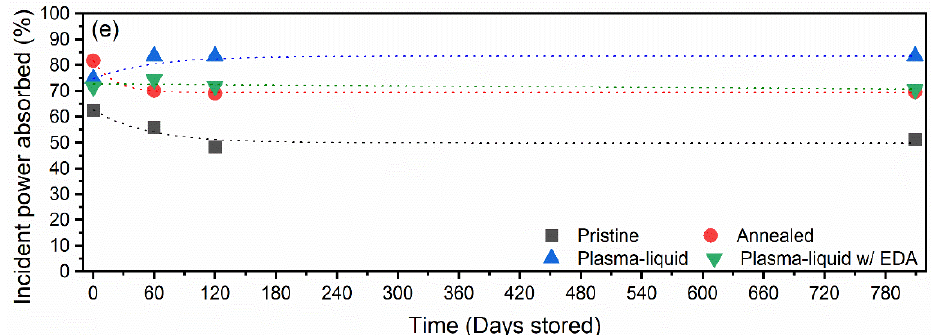
Figure 8. The values of absorption and scattering coefficients obtained from ultraviolet–visible spectroscopy via the transmittance port and an integrating sphere ( a – d ). The percentage of incident power absorbed for each carbon-nanotube-based nanofluid over 120 days ( e ).